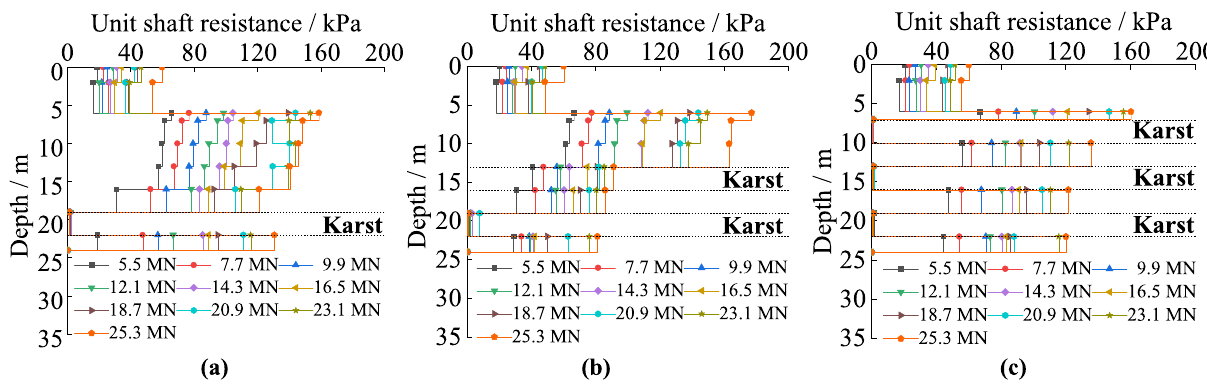
Figure 8. The unit shaft resistance of the piles with different numbers of karst caves: ( a ) cave’s number is one; ( b ) cave’s number is two; ( c ) cave’s number is